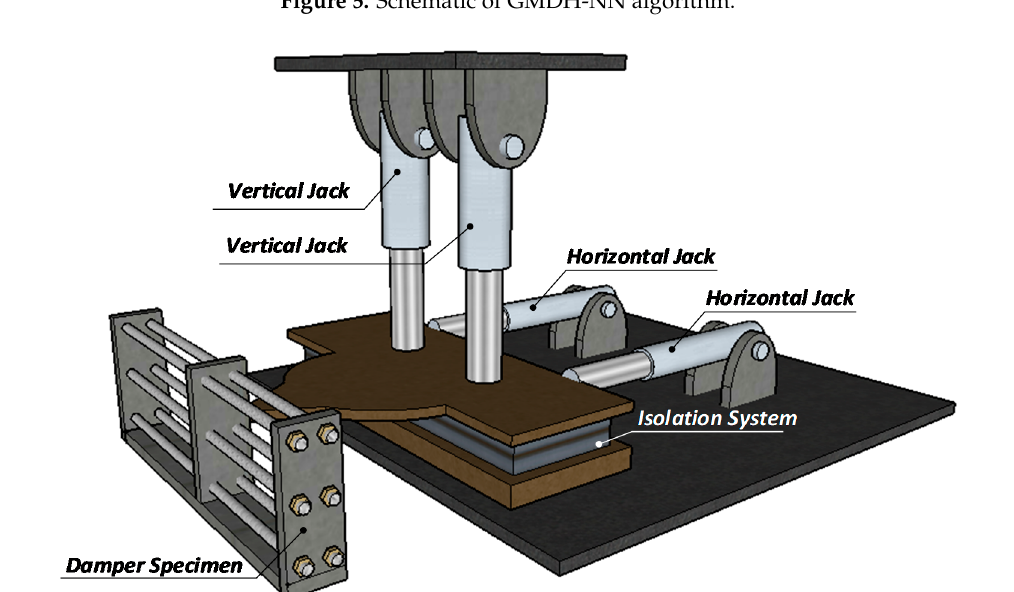
Figure 6. The test device of steel bar hysteretic damper and integrated isolator system.